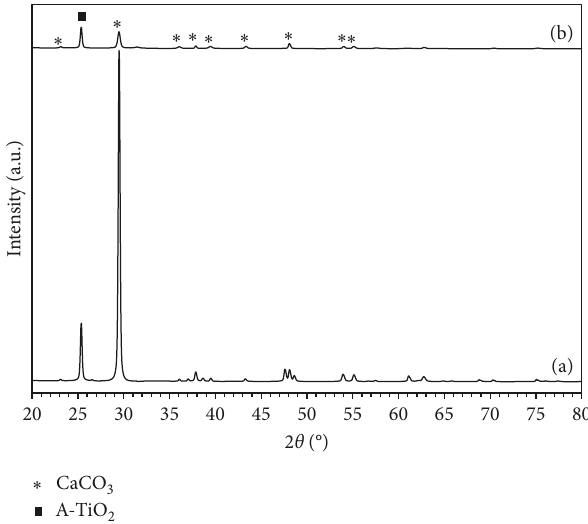
2 (a) ball-milled for 2 ob-